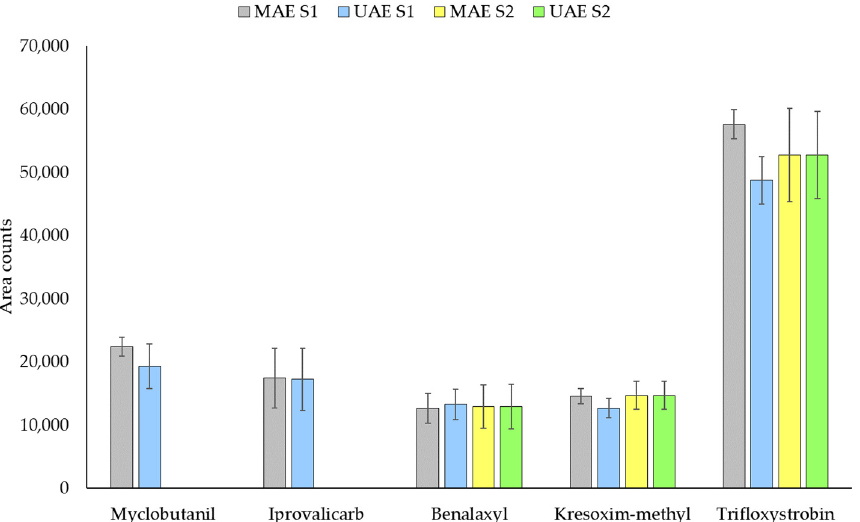
Figure 7. Comparison of UAE and MAE in soil samples (S1 and S2). Table 5. Concentration ± SD (ng g − 1 ) of fungicides in soil samples by UAE-GC-MS/MS. Samples